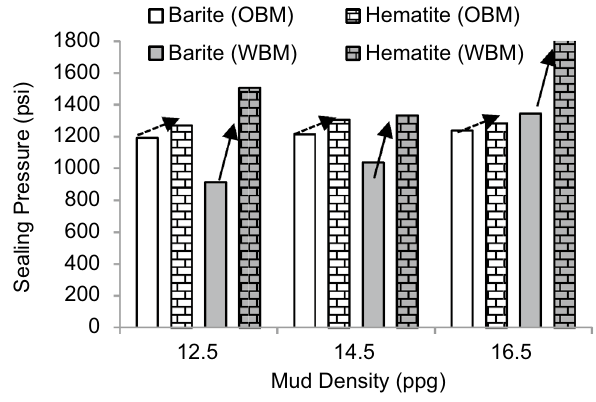
Fig. 3 Base fluid effects on sealing pressure for each LCM formula- tion. The three pairs of WBF and OBF on the left were the results from 20, 55, and 30 ppb varied concentrations, while the three pairs on the right were 105 ppb